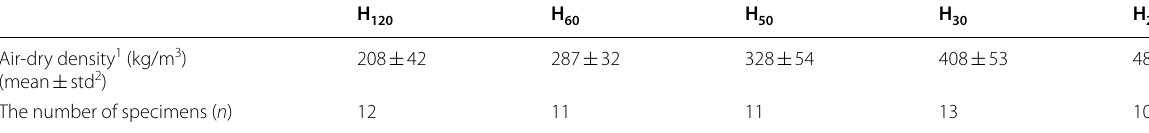
Table 2 Air-dry densities of the waste mushroom bed for thermal conductivity measurement